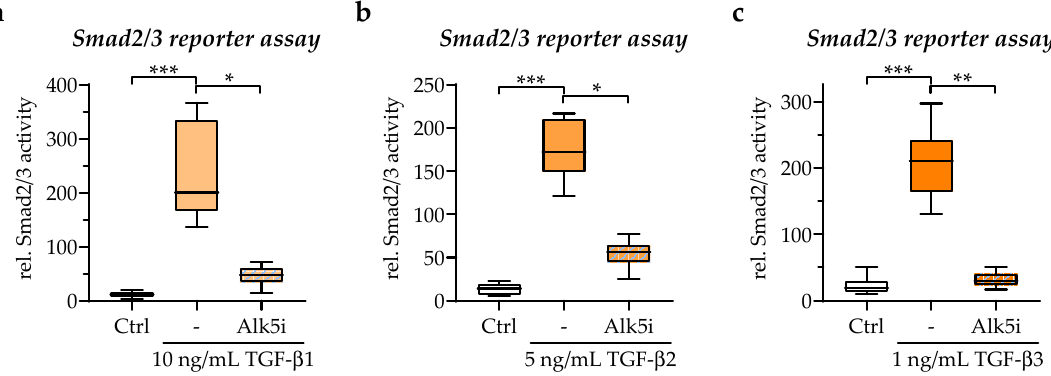
Figure 5. Exogenous stimulation with recombinant human TGF- β 1-3 activates TGF- β signaling in the in vitro scabs. ( a ) 10 ng/mL of TGF- β 1, ( b ) 5 ng/mL of TGF- β 2, and ( c ) 1 ng/mL of TGF- β 3 significantly induced TGF- β signaling in the in vitro scabs. TGF- β signaling was detected with an adenoviral-based reporter assay. The addition of 500 nM of ALK5i (SB431542) effectively blocked TGF- β signaling from all three TGF- β isoforms. Data are presented as box plots. Data were compared by non-parametric one-way ANOVA followed by Dunn’s multiple comparison test. * p = 0.05, ** p = 0.01, and *** p = 0.001.